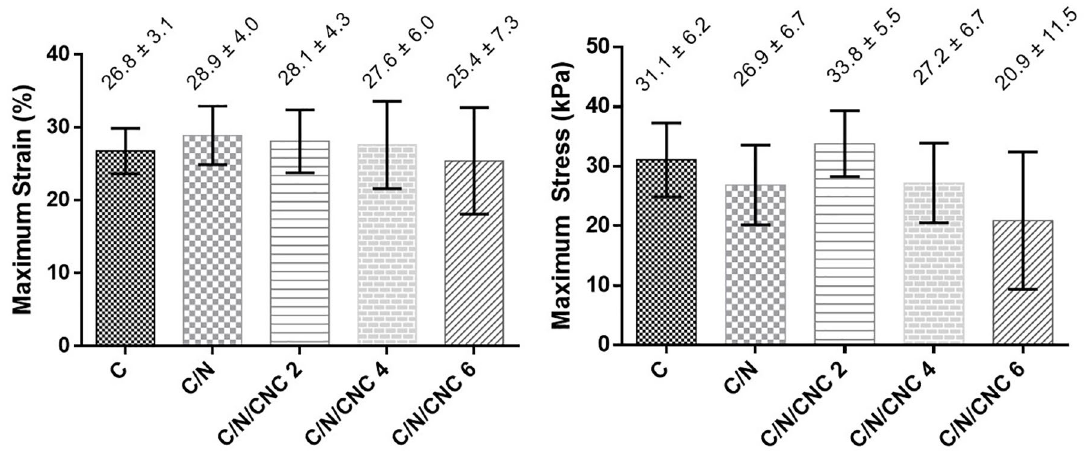
Figure 8. Maximum strain (%) and maximum stress (%) of hydrogels.